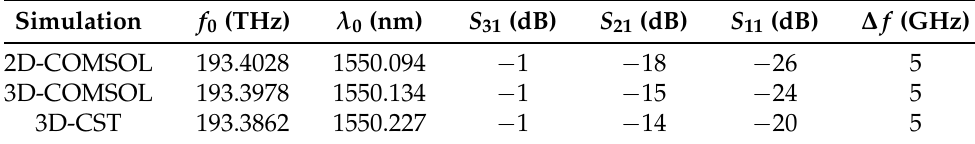
Table 1. Results obtained from the performed computational